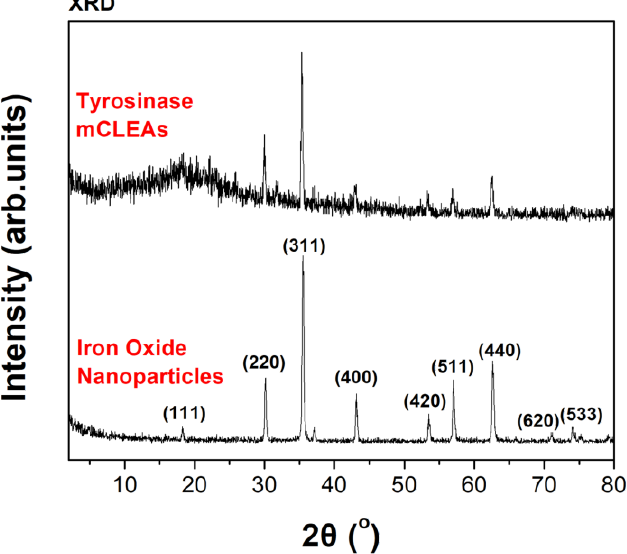
Figure 3. XRD patterns of iron oxide nanoparticles and tyrosinase